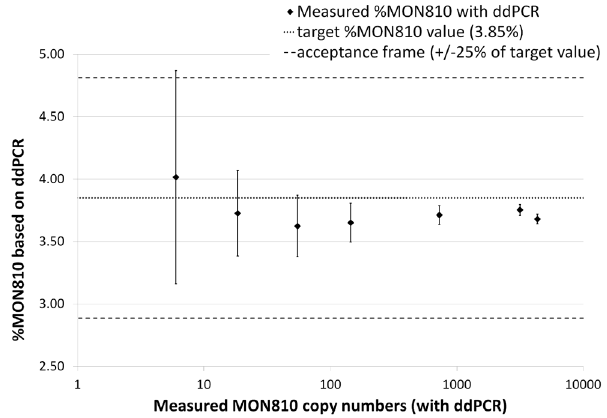
Figure 3. Precision of the duplex ddPCR assay as a function of the target concentration. MON810 content measured by ddPCR in five series of seven target concentrations. The target MON810 content (3.85%) is indicated by a dotted line. Acceptance criterion for precision is 6 25% of the target content (from 2.89% to 4.81%) represented by the dashed lines. Error bars represent the standard deviation of the measured MON810% by ddPCR at each target concentration (five replicates per target concentration).